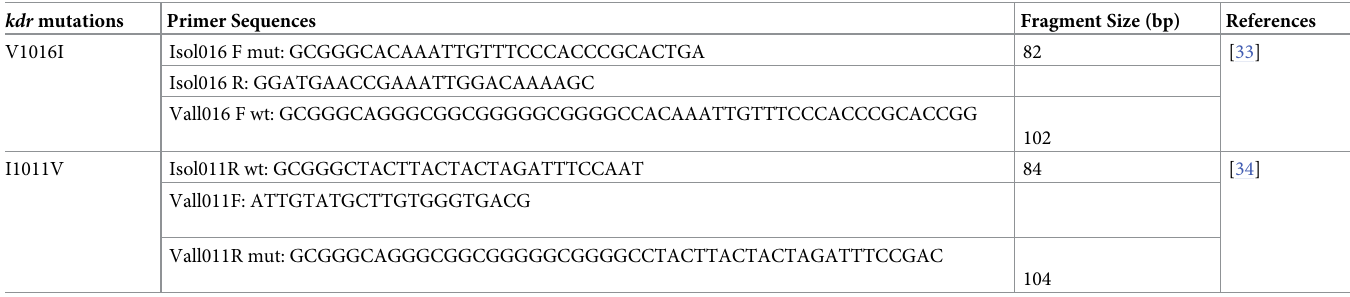
Table 1. List of Primer sequences used in detecting allele specific kdr mutations. F and R denote the forward and reverse primers respectively, while wt and mut signify wild-type and mutant sequence respectively. kdr mutations Primer